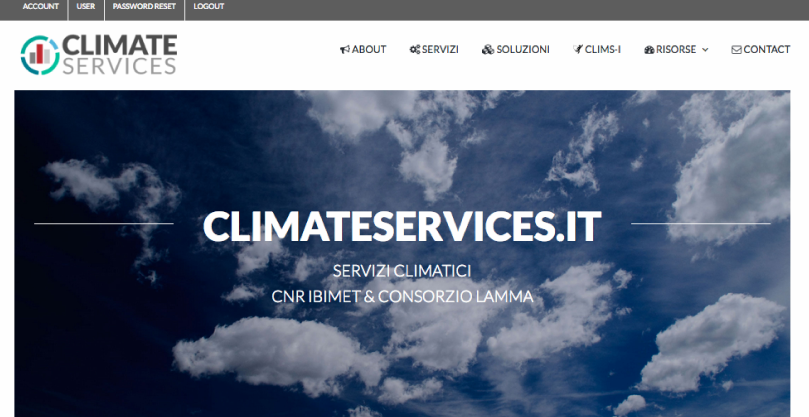
Figure 2. Home page of “climateservices.it”